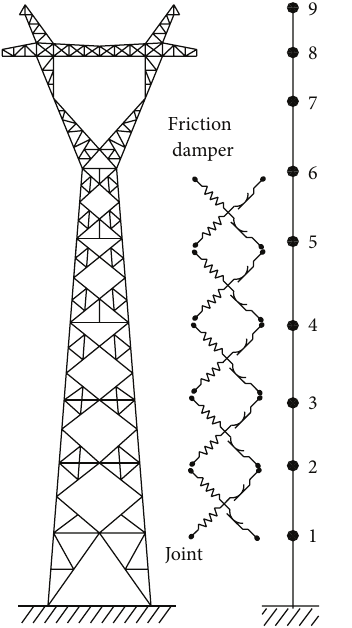
Figure 6: Installation scheme of friction damper.